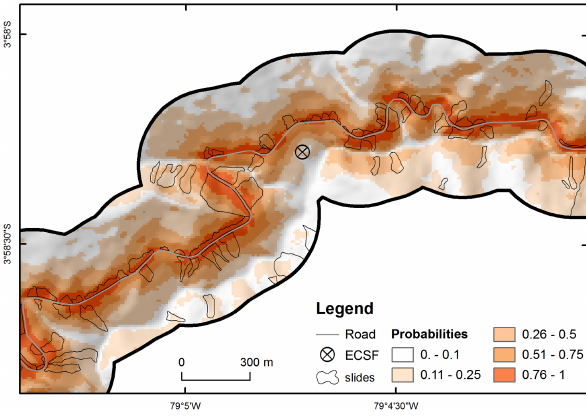
Figure 5. Landslide susceptibility index maps for a portion of the study area (Fig. 1) based on the